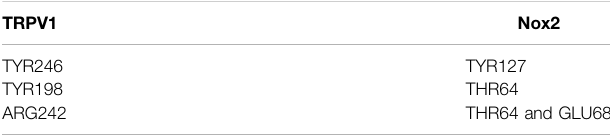
TABLE 2 | The binding sites of Nox2 and TRPV1 protein.